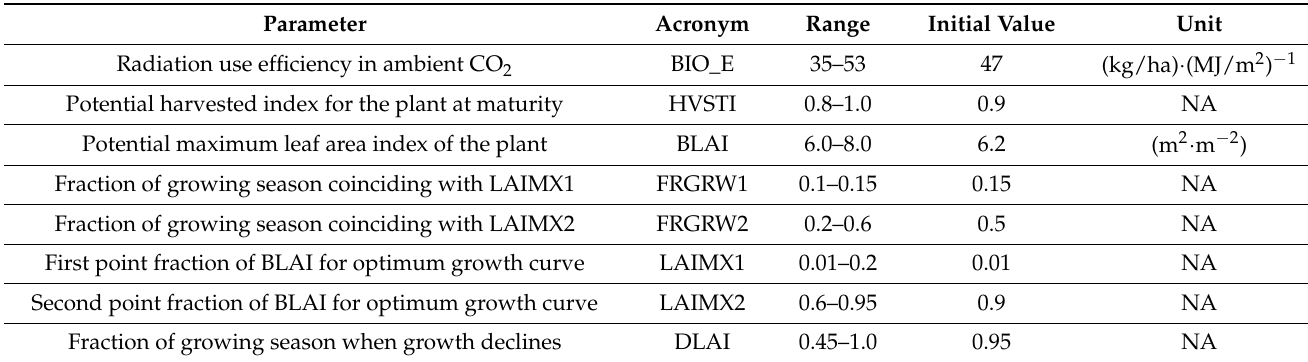
Figure 1. Simulation results for the development of LAI (red line) of Napier grass with the set of parameters (initial parameters) obtained from Gil et al. [26], and the comparison of experimental yield at harvest (black squares) and simulated yield (black line) at Sukhothai plantation from May 2001 to April 2002 [31]. Table 1. List of parameters for Napier grass in the SWAT2012 crop database